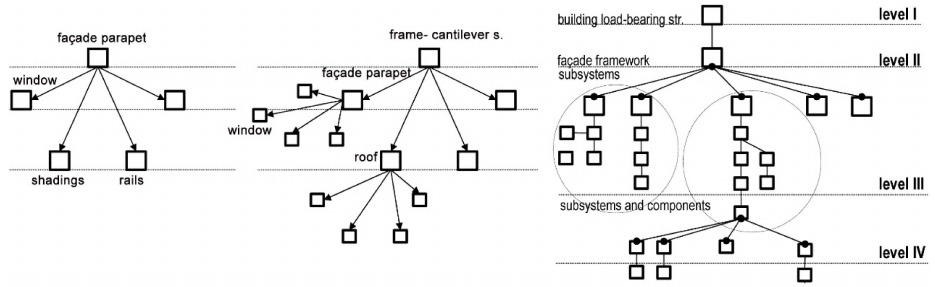
Figure 17. Schematic diagram for systematization of components and systems into hierarchy assemblies